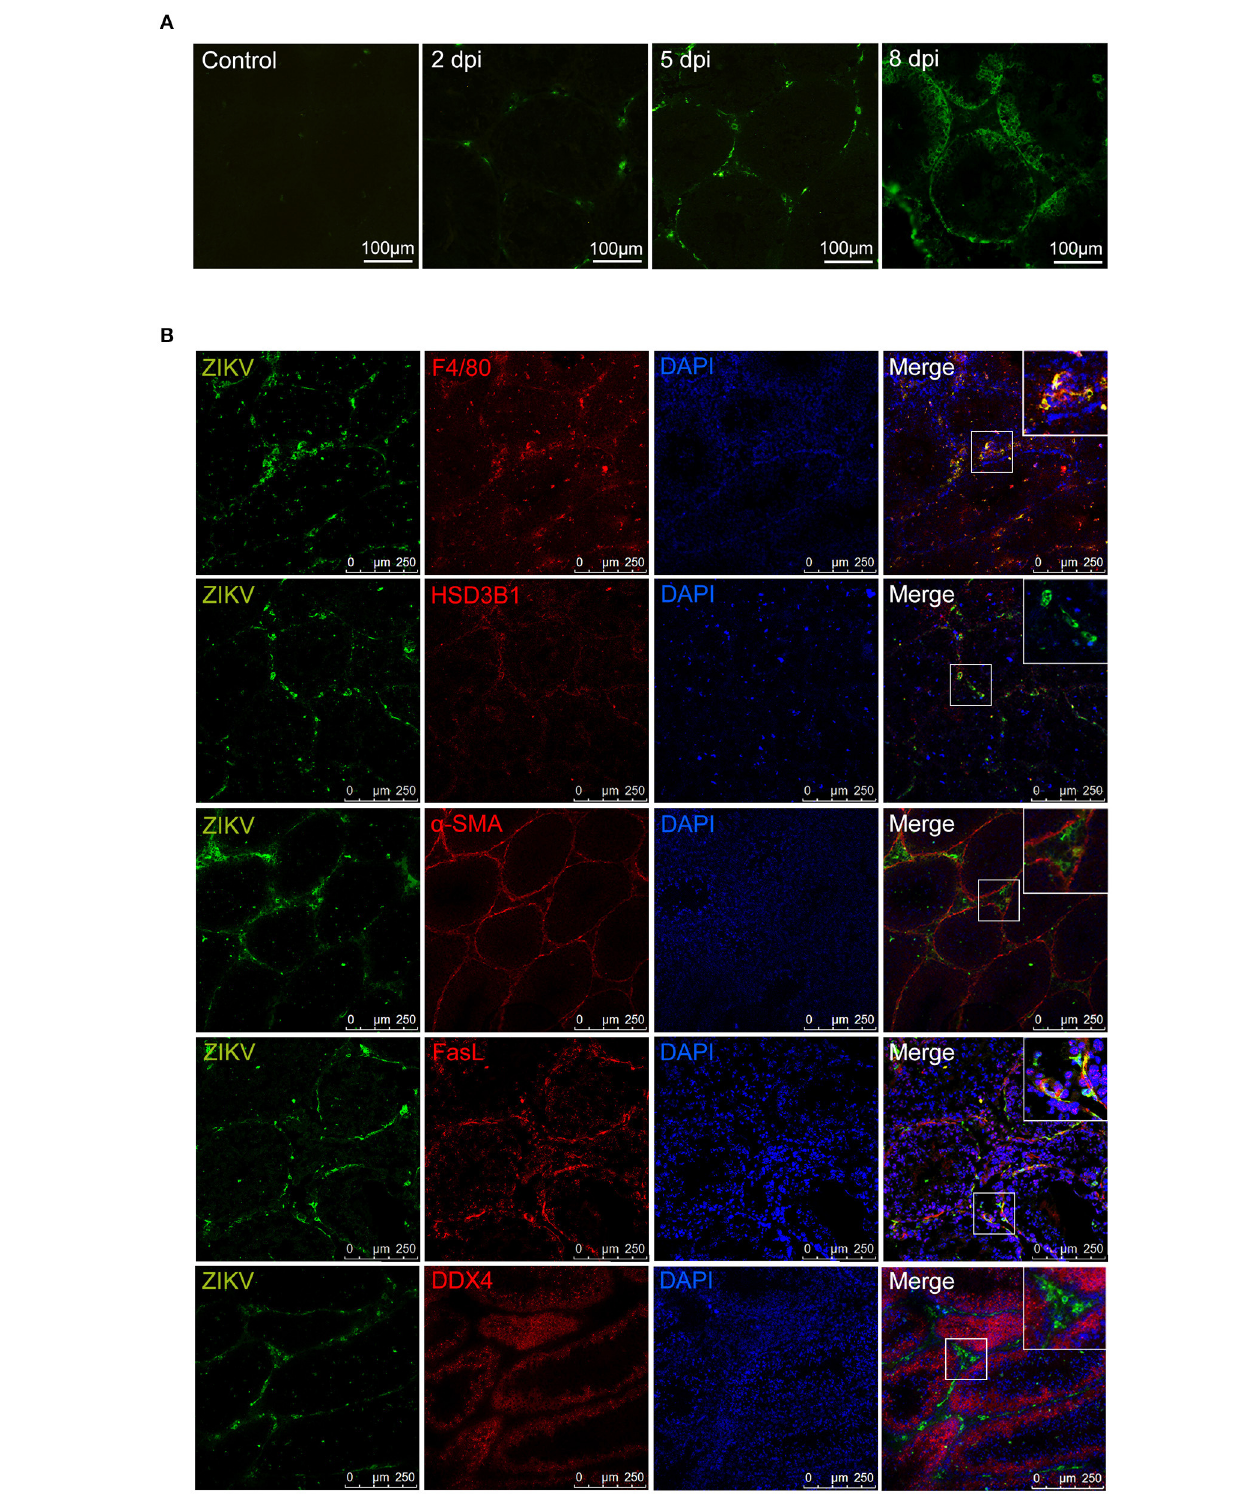
FIGURE 5 | Immunofluorescence staining for detection of ZIKV antigen in mouse testes. (A) Distribution of ZIKV antigens in testis at different time points as indicated. (B) The co-localization of ZIKV antigens with cells in ZIKV-infected testes at 5 dpi (anti-ZIKV polyclonal antibodies, in green), various cell markers in testis (in red, F4/80 for macrophages, HSD3B1 for Leydig cells, α -SMA for peritubular myoid cells, FasL for sertoli cells, DDX4 for germ cells), and staining for nuclei (DAPI, in blue).